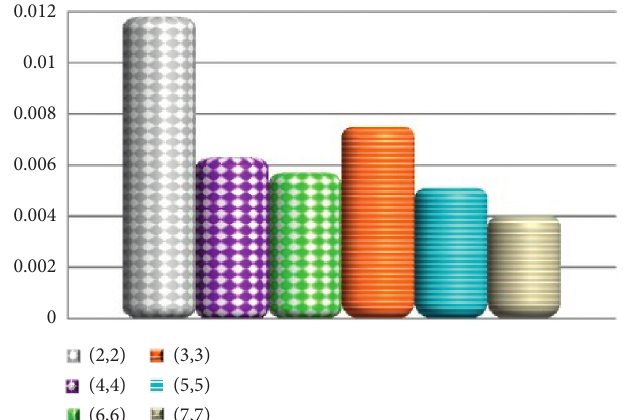
Figure 9: MSE of SSR estimate for 􏽢 R � P ( X